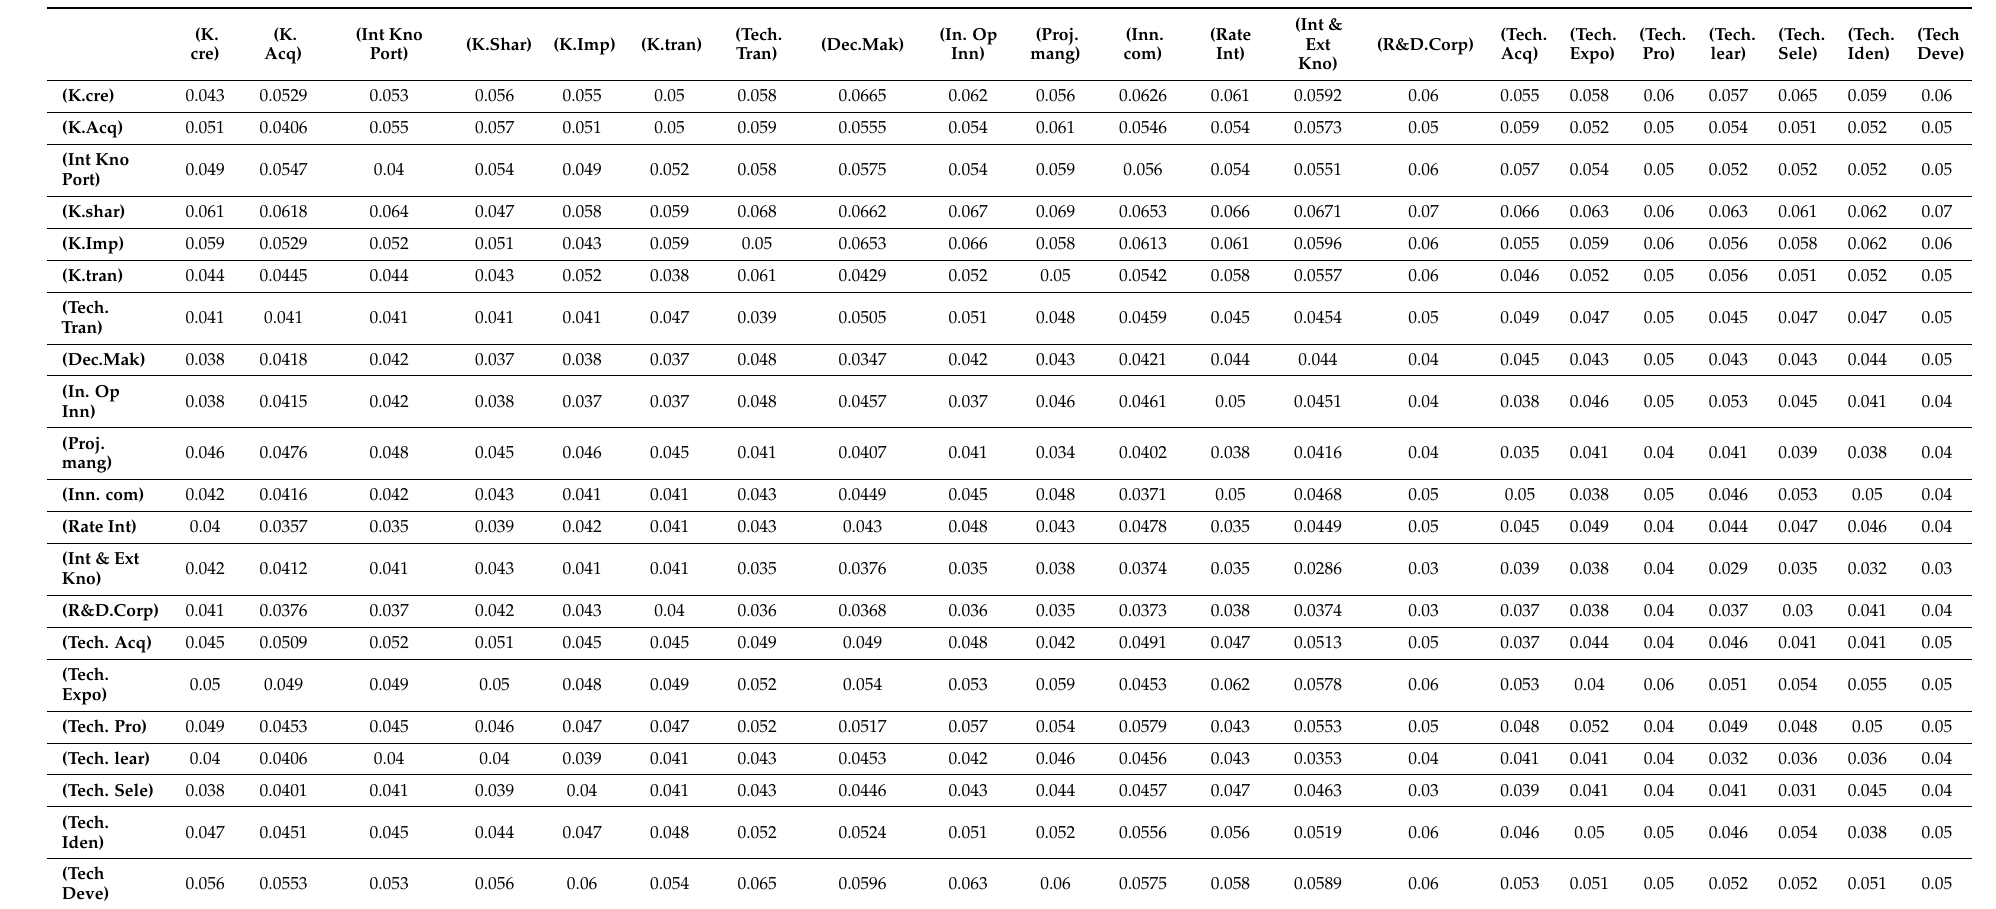
× ( T ∗ ( Criteria ) ( Dimension )